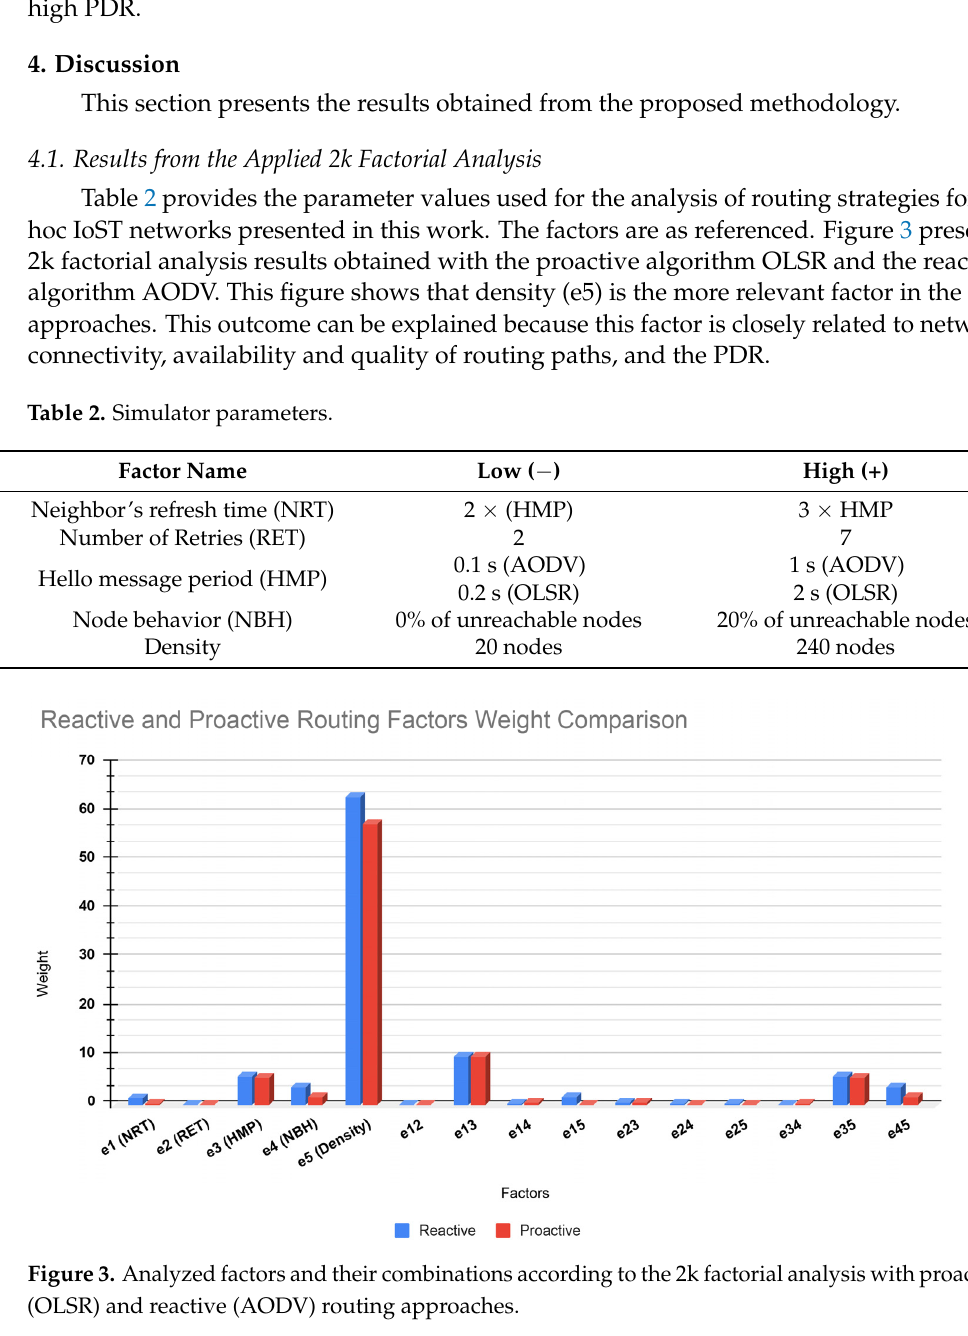
Figure 3. Analyzed factors and their combinations according to the 2k factorial analysis with proac- tive (OLSR) and reactive (AODV) routing